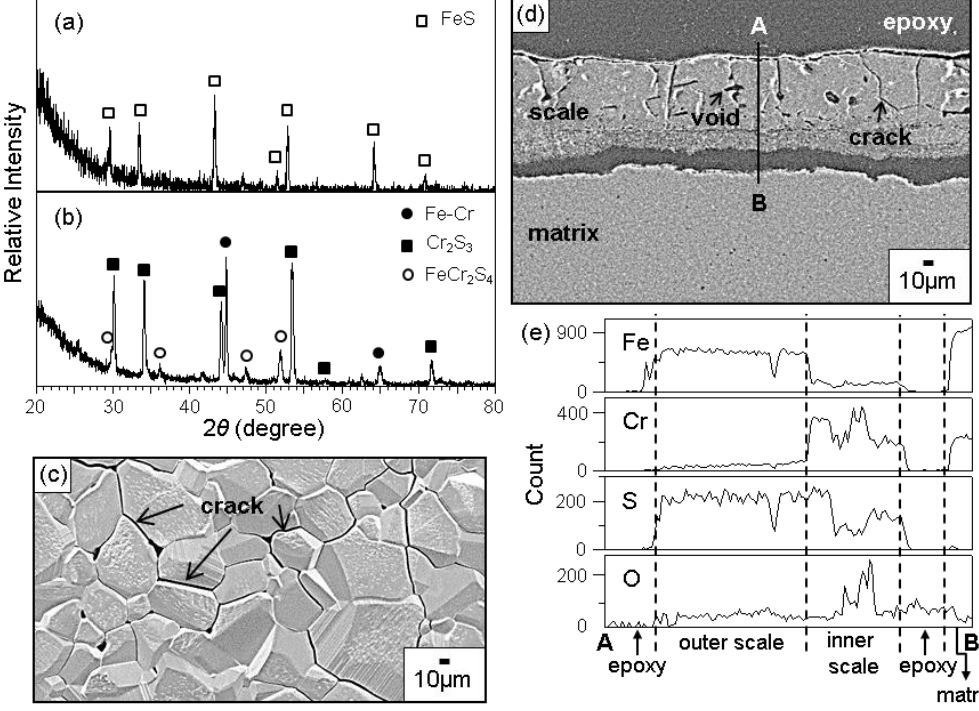
Figure 5. Fe-19Cr after corrosion at 700 °C for 40 h in N 2 /3.1%H 2 O/2.42%H 2 S. ( a ) XRD pattern after corrosion; ( b ) XRD pattern taken after grinding off the outer scale; ( c ) SEM top view; ( d ) EPMA cross-section; ( e ) EPMA line profiles of along A–B denoted in ( d ).